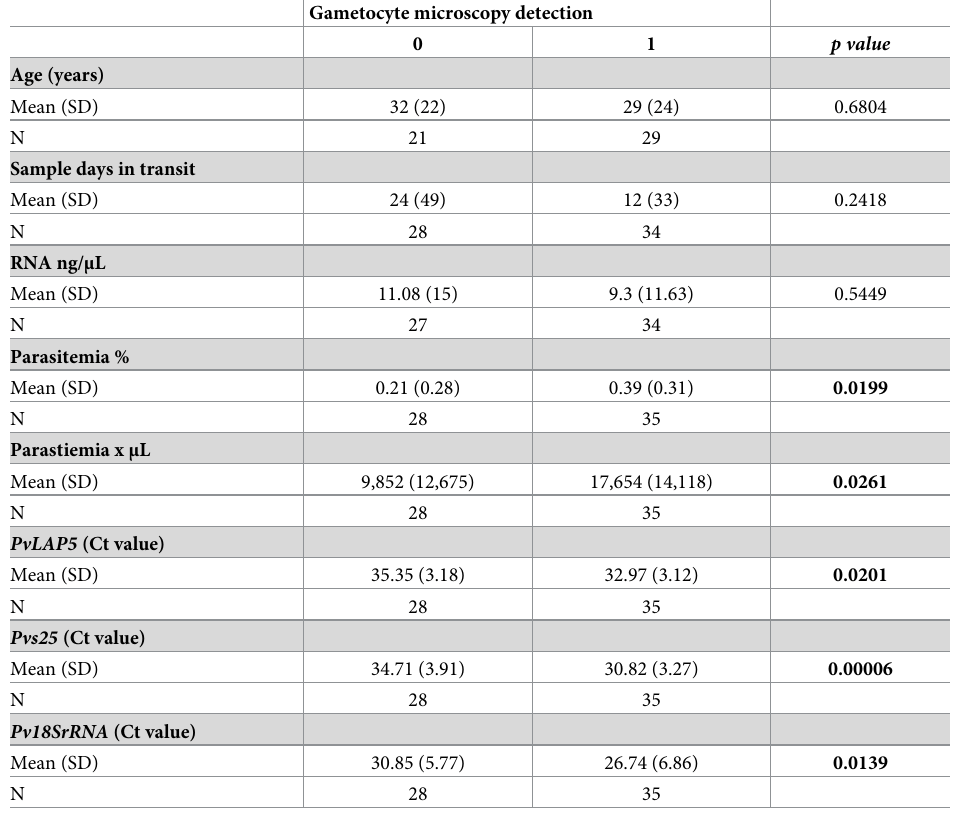
Table 2. Summary statistics of Plasmodium vivax grouped by microscopic detection of gametocytes.